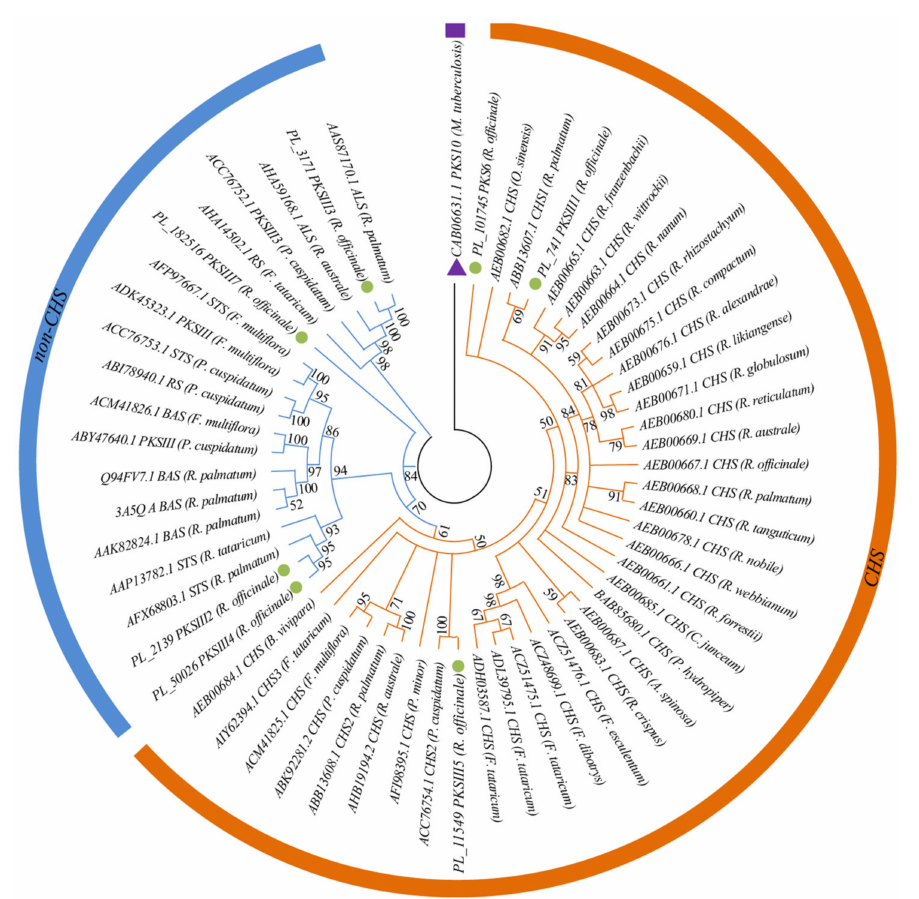
Figure 5. A maximum likelihood phylogenetic tree of the candidate genes in Polygonaceae belonging to PKS III superfamily with the bacterial PKS III Mycobacterium tuberculosis PKS10 (purple triangle) set as the outgroup. The sequences shown in the green dots represent the PKSIII gene identified in R. officinale . The numbers above the branches indicate the bootstrap values for each evolved branch in the